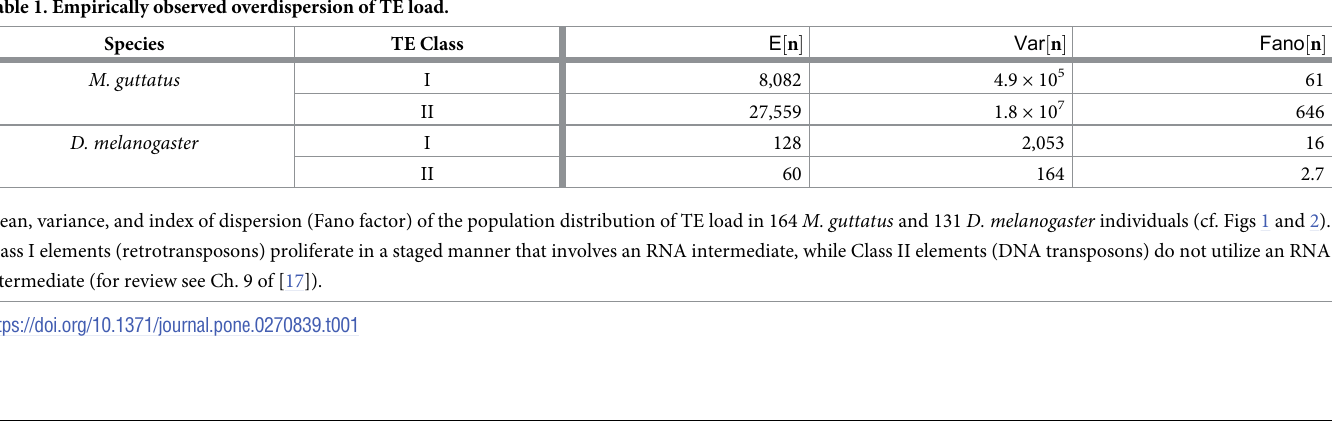
Table 1. Empirically observed overdispersion of TE load. Species M. guttatus